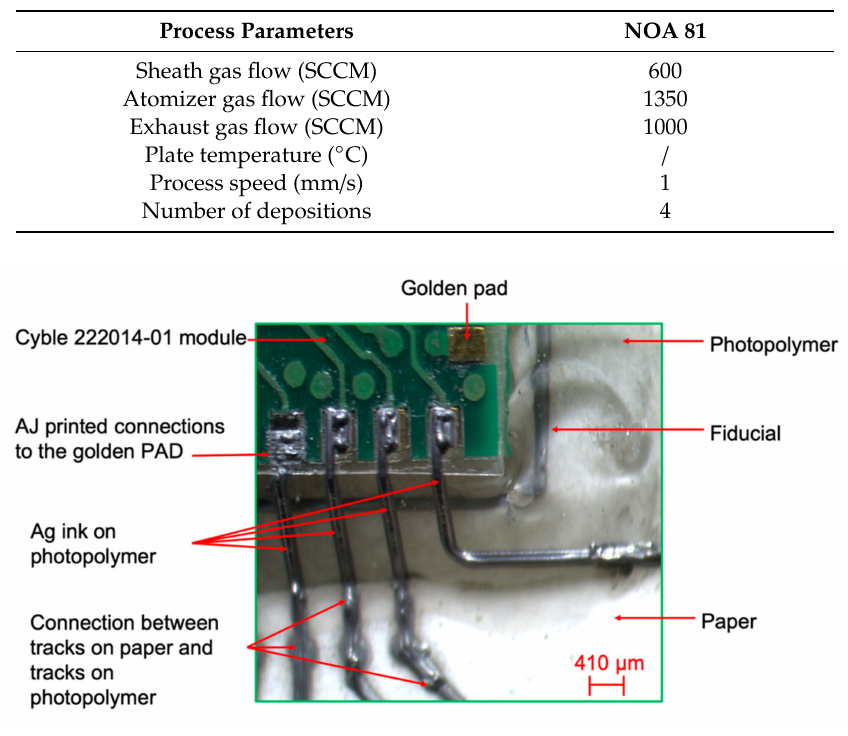
Figure 4. Details of encapsulated programming module and printed